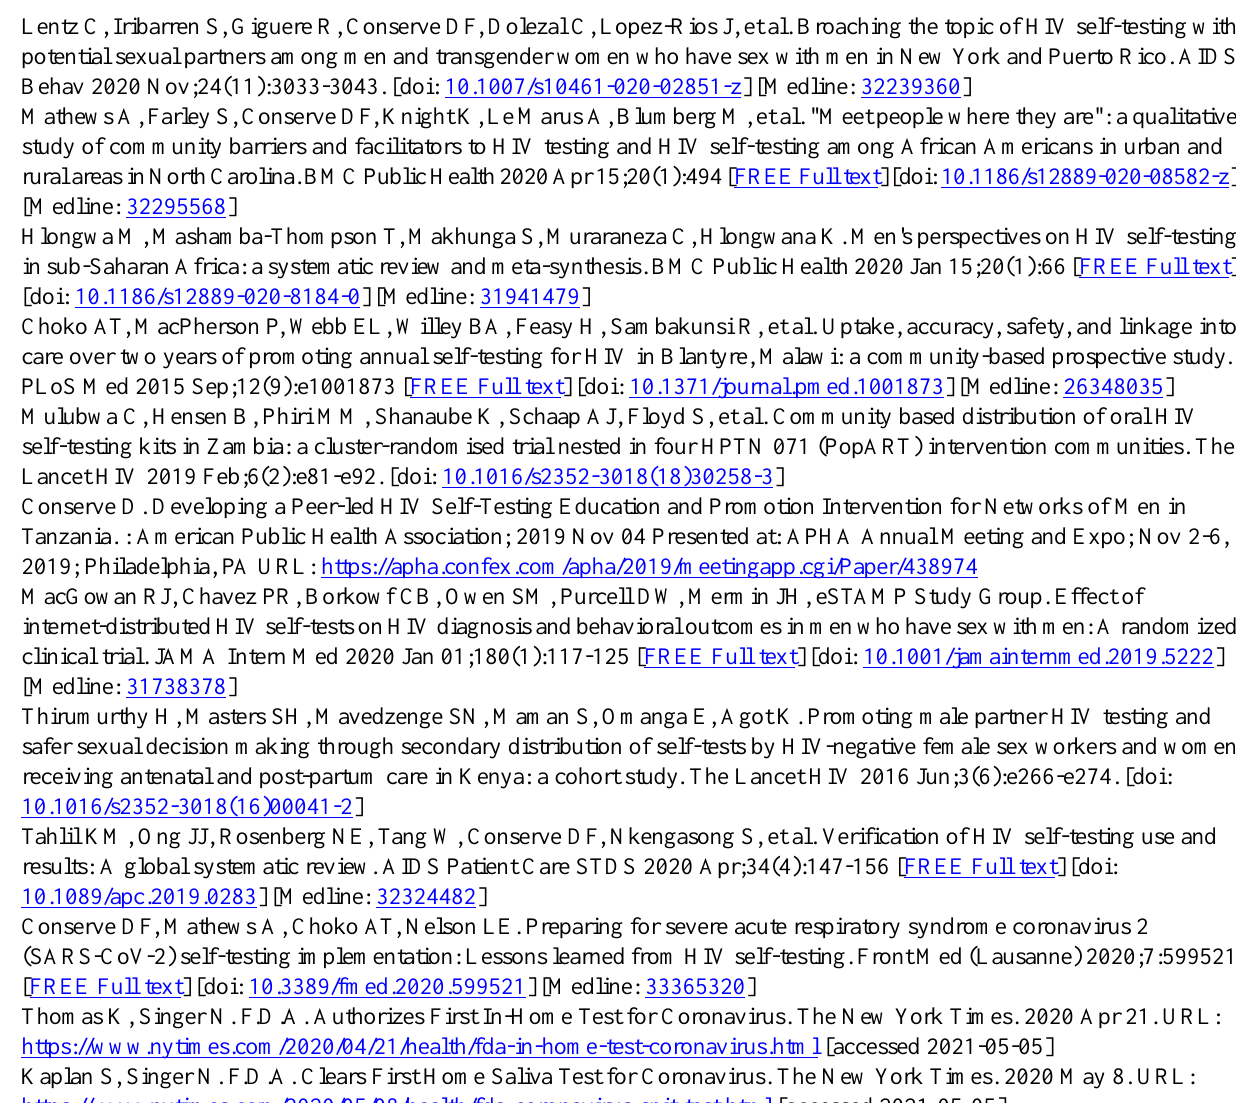
FDA: Food and Drug Administration HCW: health care worker HIVST: HIV self-testing PPE: personal protective equipment PSC: plasma separation card RT-PCR: reverse transcription–polymerase chain reaction SARS-CoV-2SS: severe acute respiratory syndrome coronavirus 2 self-sampling STAR: Self-Testing Africa WHO: World Health